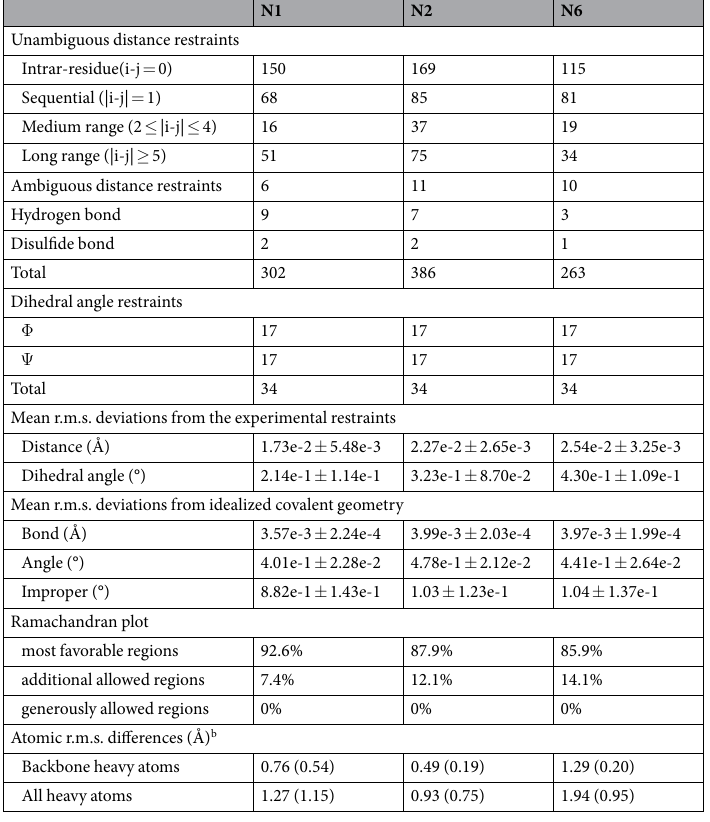
Table 3. Structure statistics for 20 conformers of the three peptides N1, N2 and N6. None of the structures exhibits distance violations greater than 0.3 Å or dihedral angle violations greater than 4˚. a The program PROCHECK (http://www.biochem.ucl.ac.uk/~roman/procheck_nmr/procheck_nmr.html) was used to assess the overall quality of the structures; b The numbers in the parenthesis are the rms differences for the well-ordered region (residues 3–20 for N1, residues 2–20 for N2, and residues 3–19 for